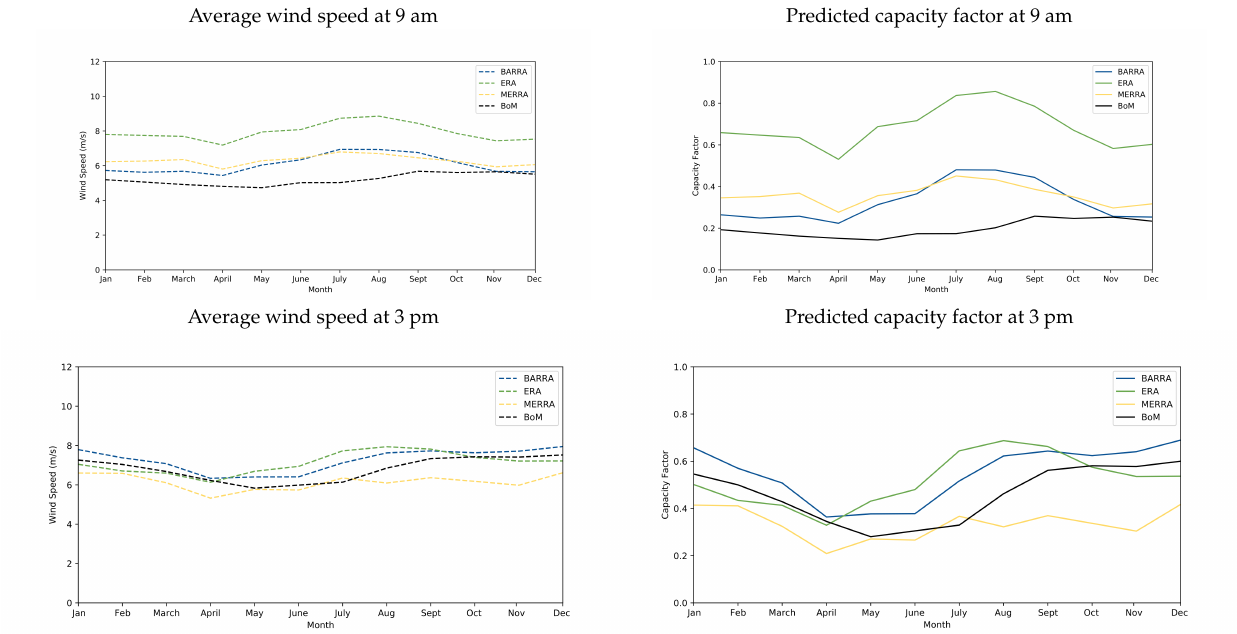
Figure 12. Comparison between average wind speed at 150 m across key locations and corresponding capacity factor predicted using each data